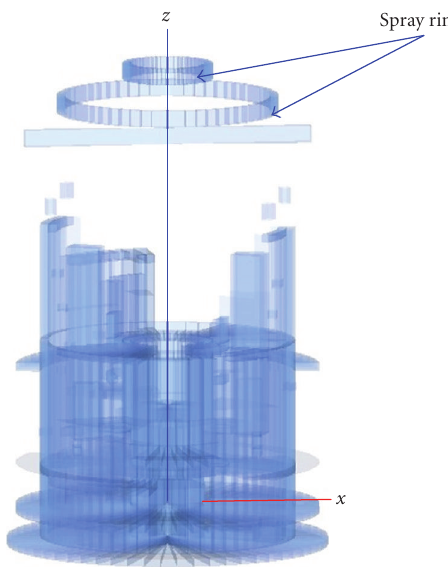
Figure 2: Containment geometry